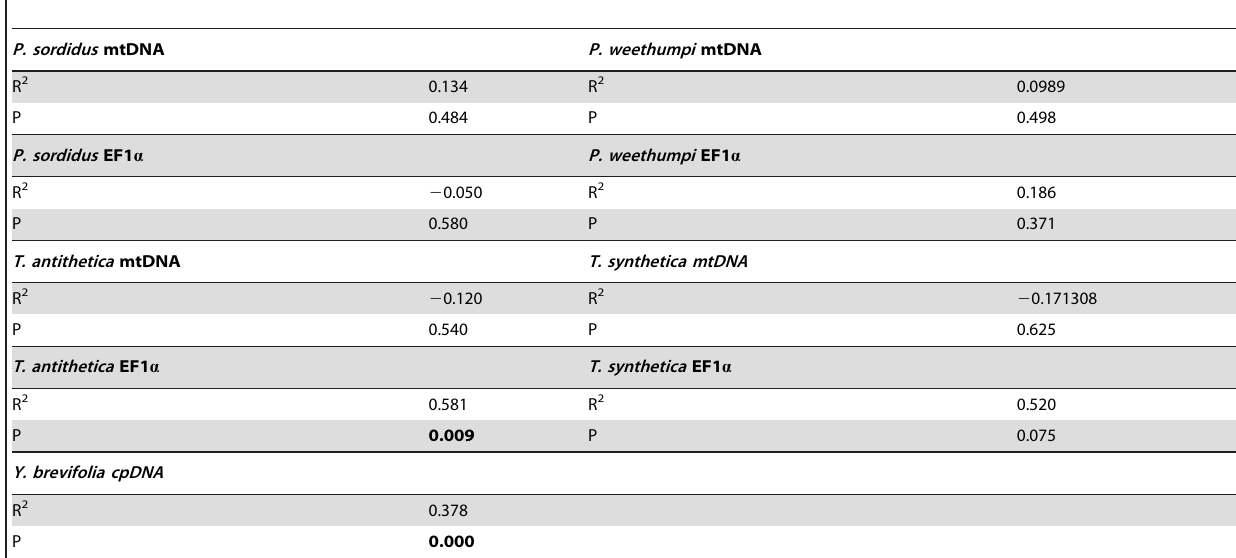
Table 7. Results of Mantel tests comparing geographic distance with pairwise F ST scores between populations, estimated in Arlequin v.